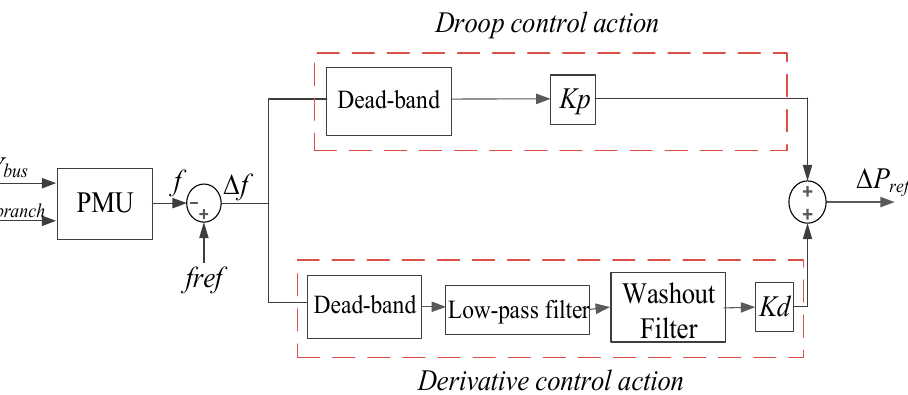
Figure 4. Block diagram of the droop derivative-based FAPR strategy.